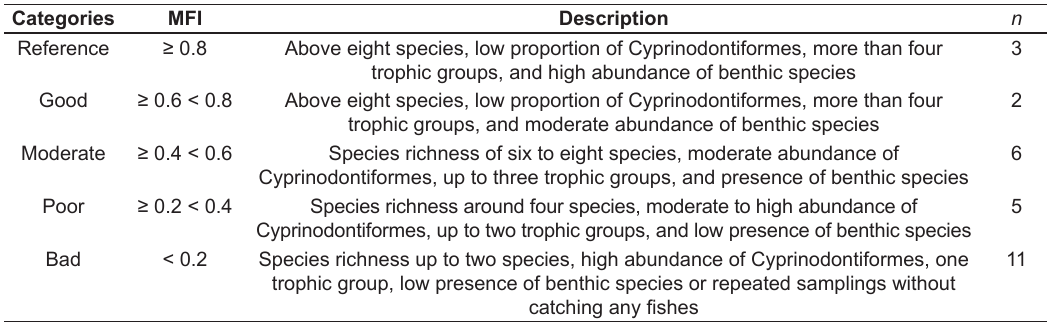
Table 8. Detailed descriptions of stream multimetric fish index (MFI) with ecological quality ratio (EQR) values and number of streams by category ( n